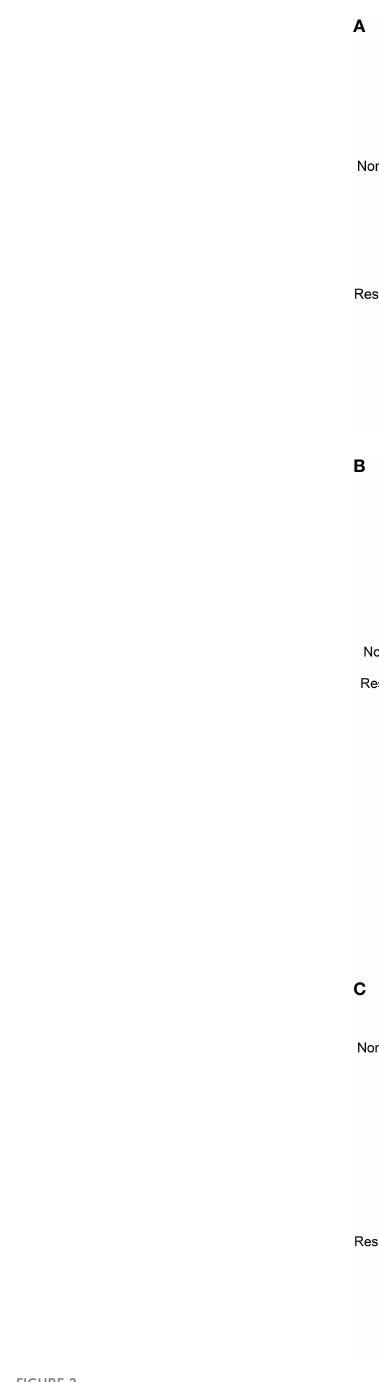
FIGURE 2 Distribution by site. (A) Overall, (B) Adult, and (C) Childhood cancers. ALL, Acute lymphoblastic leukaemia; CML, chronic myeloid leukaemia; CNS, Central Nervous System; NHL, non-Hodgkin lymphoma; AML, Acute myeloid